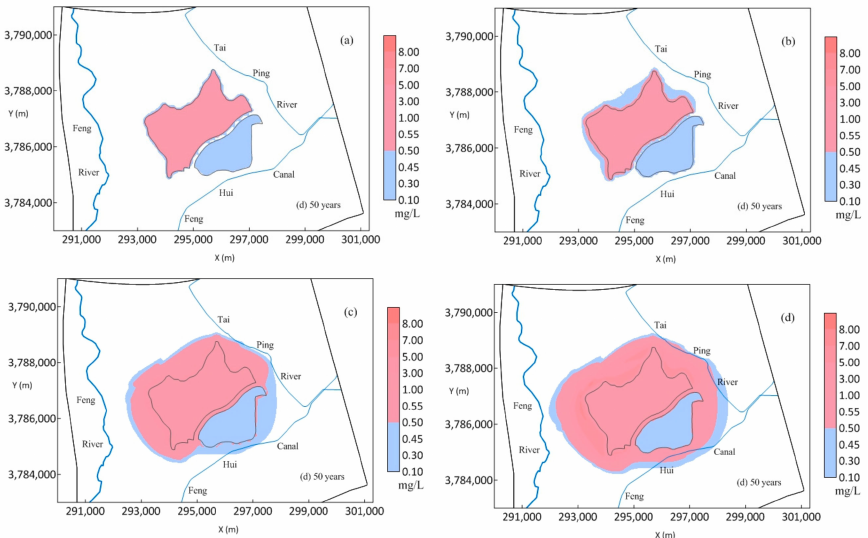
Figure 12. NH 3 -N transport of ( a ) 3 years; ( b ) 10 years; ( c ) 20 years; ( d ) 50 years after water storage in DR.